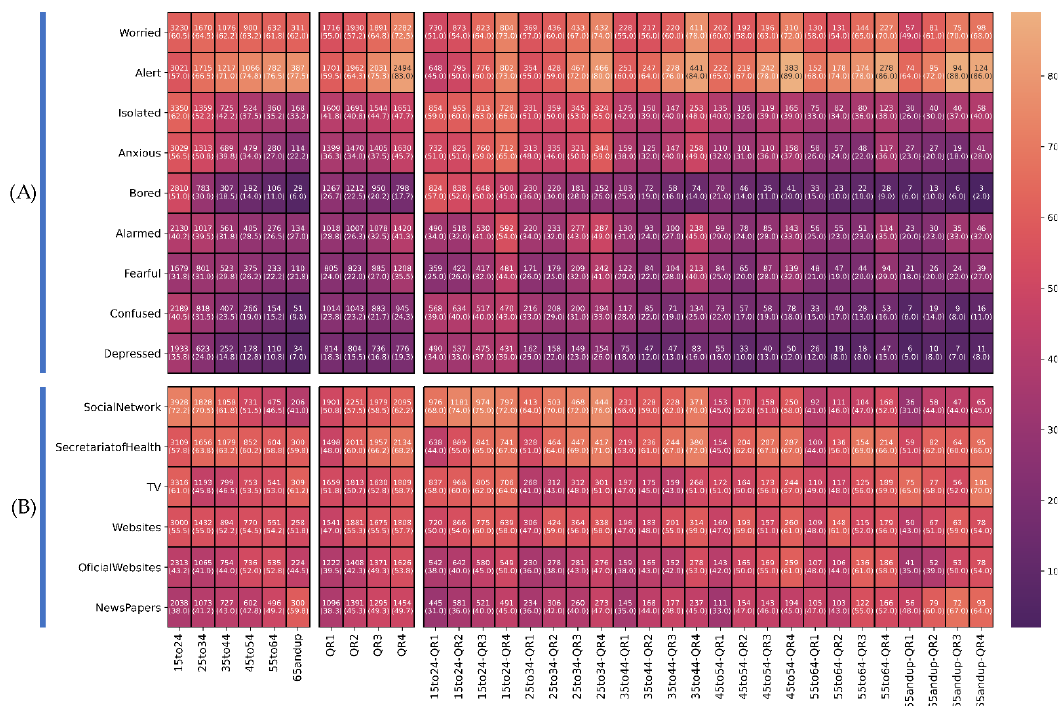
Figure 4. Relation between the perception of risk and age and the emotions. ( A ) reported by the individuals and the media consulted ( B ). All groups are reported with a p < 0.01 illustrating the total number of individuals (percentage of the total group). The more intense the colour, the higher the frequency on the